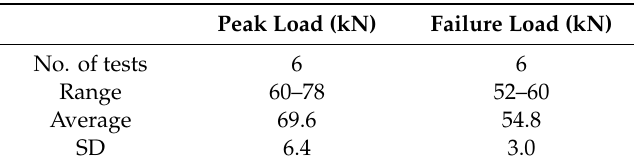
Table 12. Peak-load average value and standard deviation.